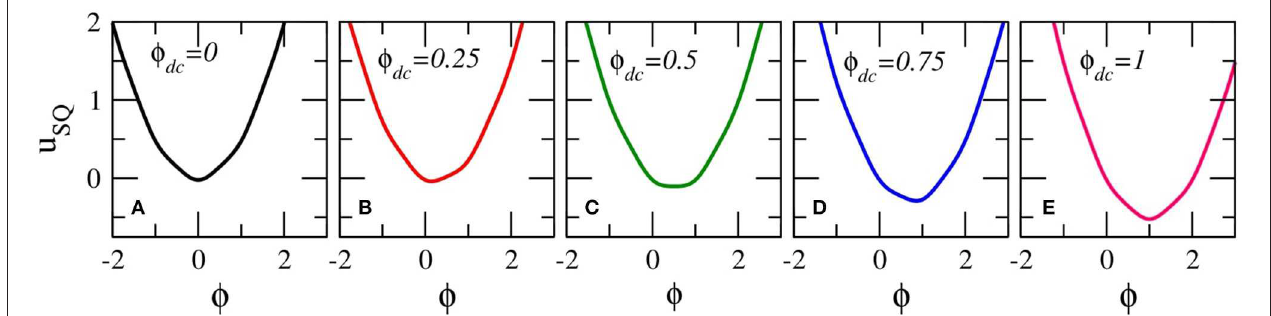
FIGURE 3 | Flux amplitude–driving frequency ( φ max with β L 0.86, γ 0.01, φ dc 0, and (A) φ ac = = = (C) φ ac 10 − 2 , (D) φ ac 10 − 1 = =